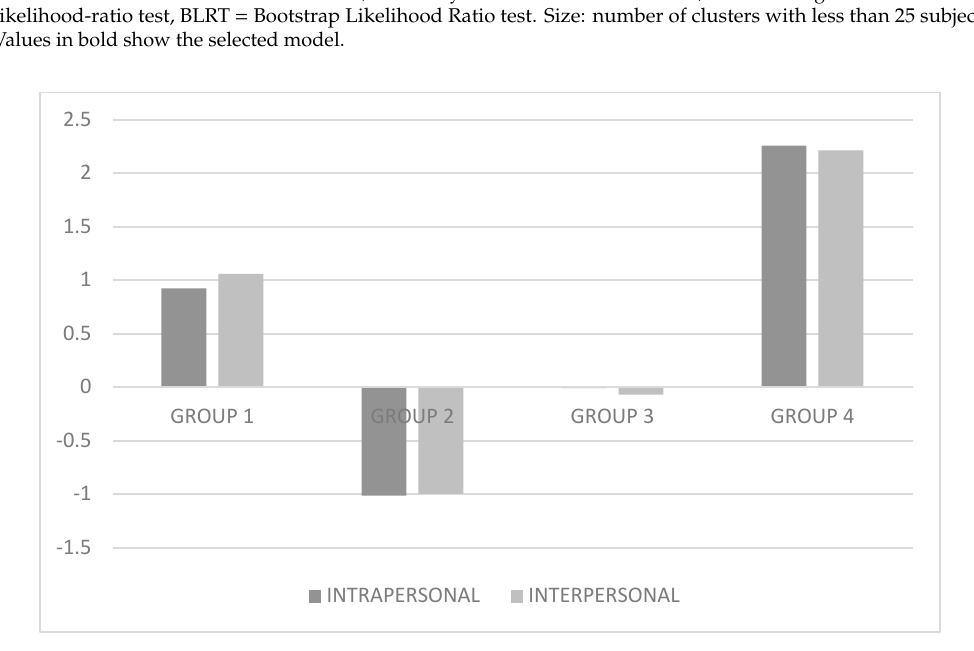
Figure 1. Graphical representation of the four-profiles. Group 1 (Problematic use), Group 2 (Non-problematic use), Group 3 (Moderate problematic use), and Group 4 (Severe problematic use).